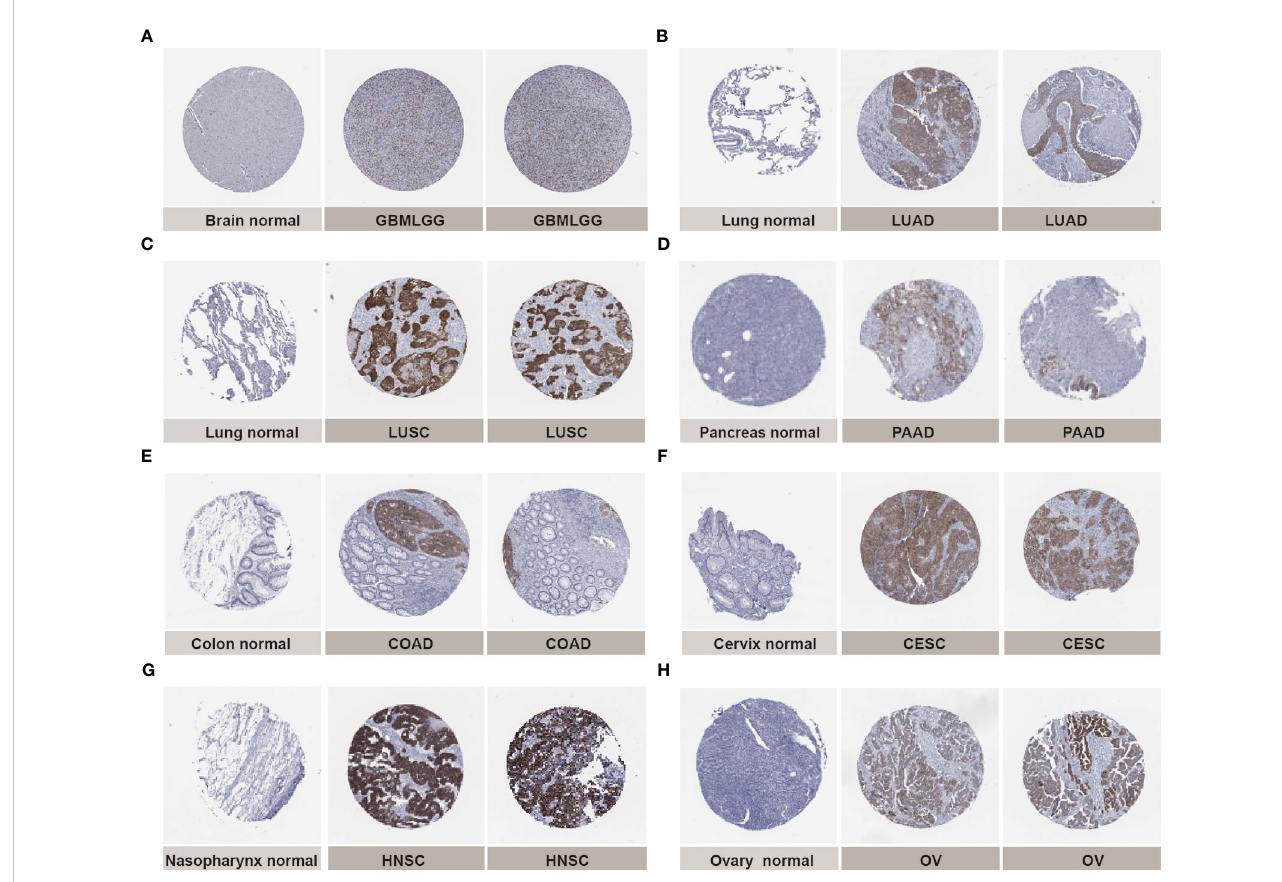
FIGURE 2 Representative immunohistochemical staining (IHC) in multiple normal (left) and tumor (right) tissues. The protein expression of IGF2BP3 in (A) glioma, GBMLGG; (B) lung adenocarcinoma, LUAD; (C) lung squamous cell carcinoma, LUSC; (D) pancreatic adenocarcinoma, PAAD; (E) colon adenocarcinoma, COAD; (F) cervical squamous cell carcinoma and endocervical adenocarcinoma, CESC; (G) head and neck squamous cell carcinoma, HNSC; (H) ovarian serous cystadenocarcinoma,